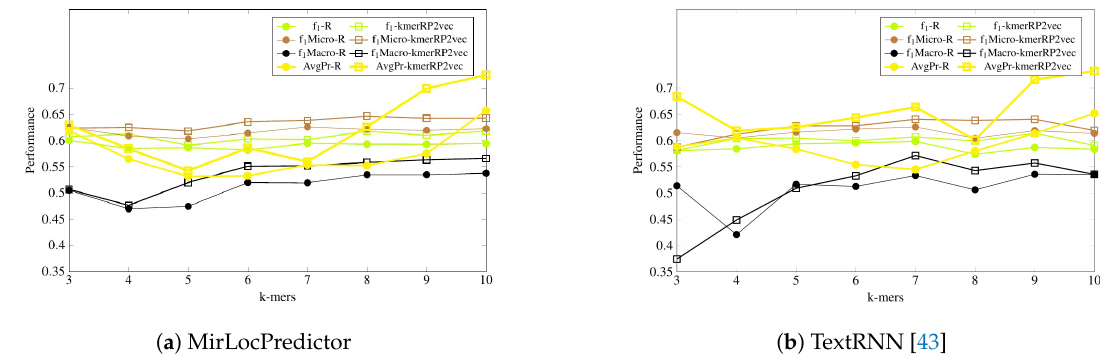
Figure 5. Performance comparison of the proposed kmerPR2vec with randomly initialized k-mer embeddings at 8 benchmark k-mers using two classification